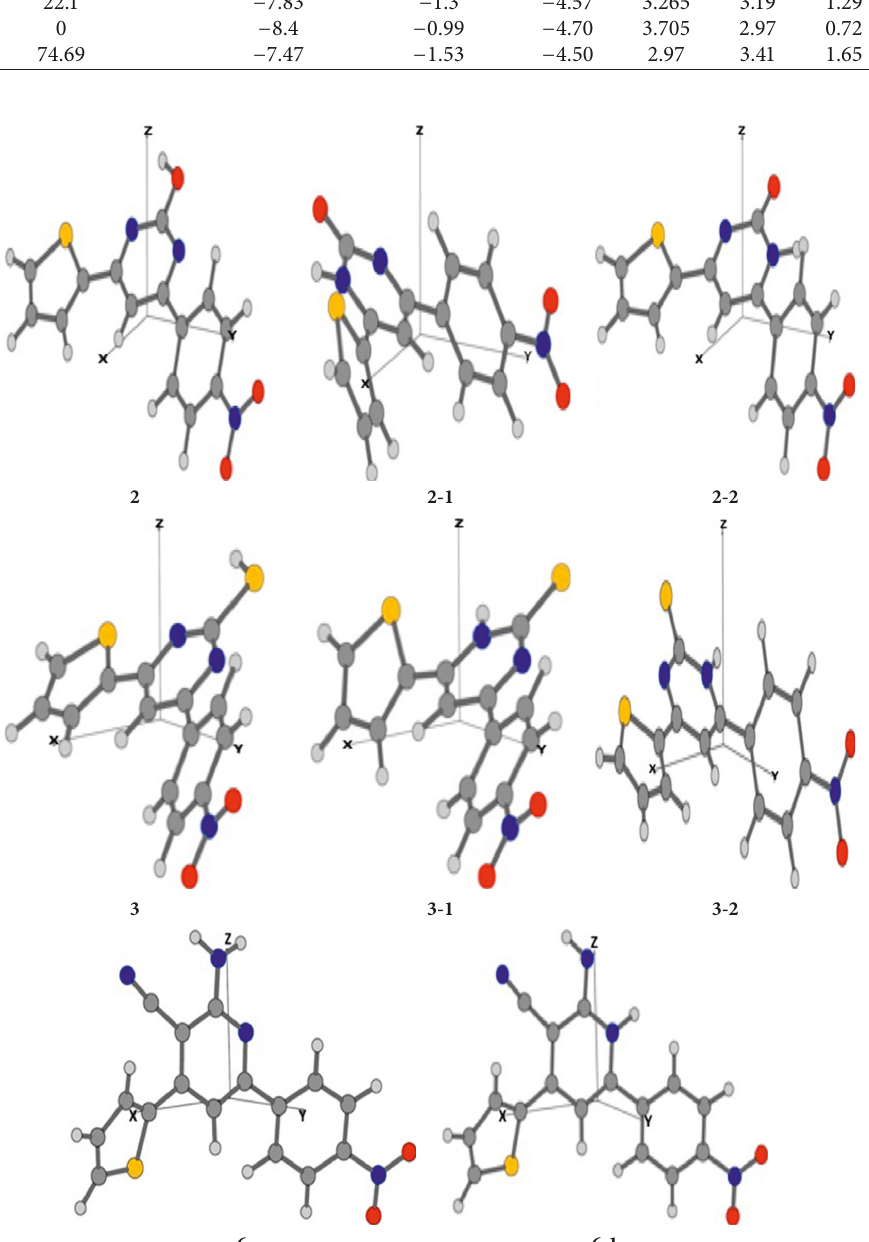
Figure 4: Optimized geometries of the tautomers of molecules 2 , 3 , and 6 .